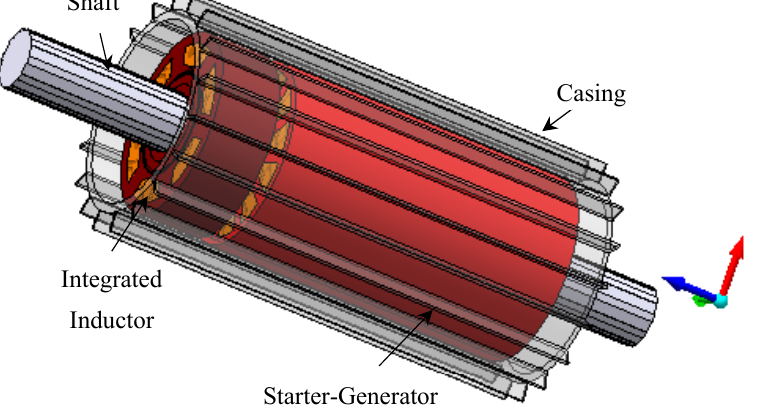
Figure 9. Motor-shaped Integrated Inductor.